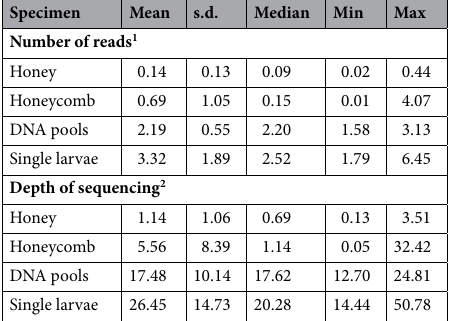
Table 2. Sequencing data summaries of the number of reads and depth of sequencing. 1 Data are expressed in millions. 2 Data are expressed in